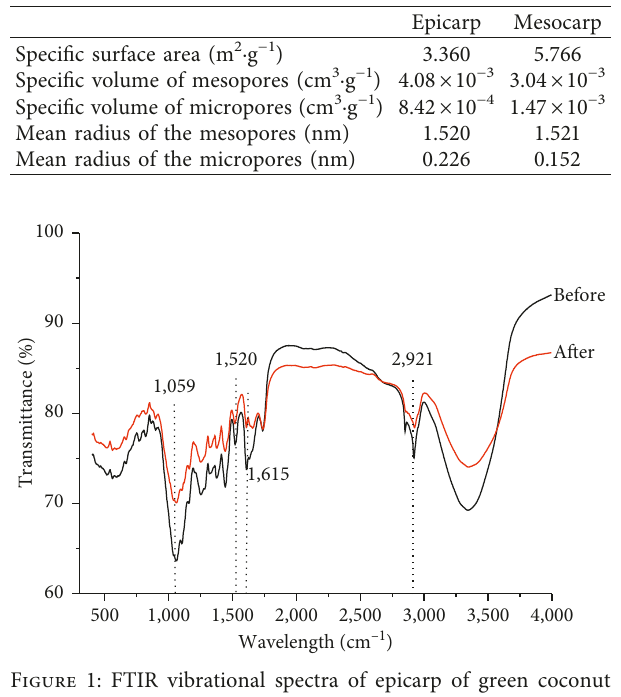
Table 1: Textural properties of dried epicarp and mesocarp of green coconut.